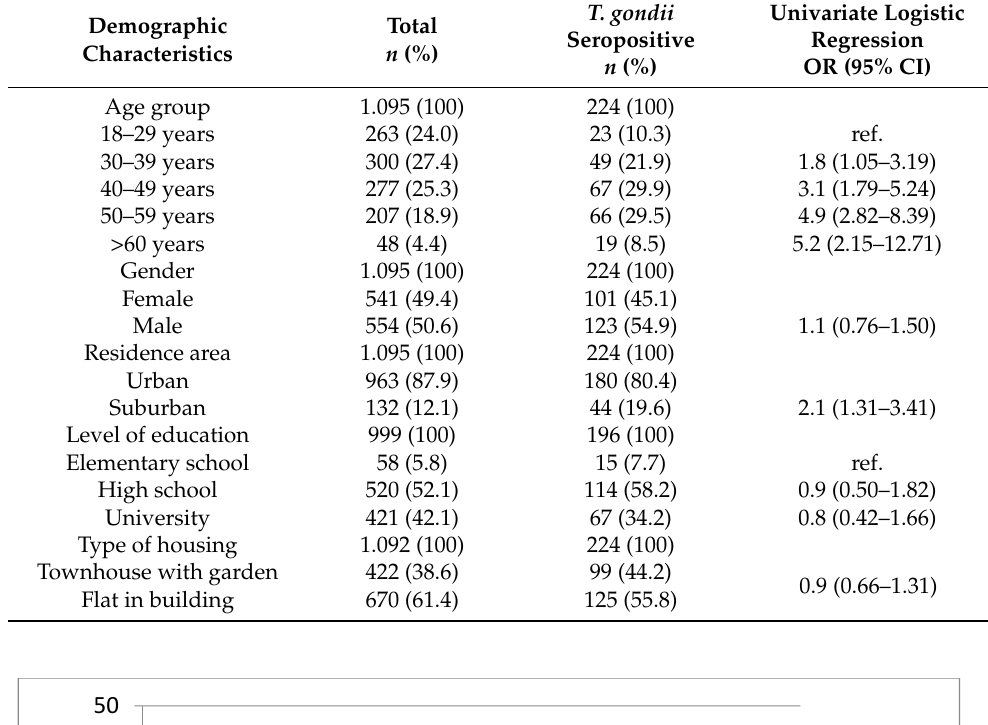
Table 1. Demographic characteristics of participants and univariate logistic regression analysis for T. gondii infection.